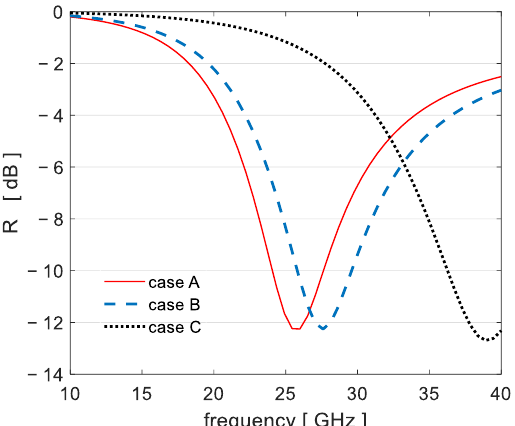
Figure 9. Frequency spectra of the reflection coefficient for the cases A, B and C shown in Table 2 for normal incidence.